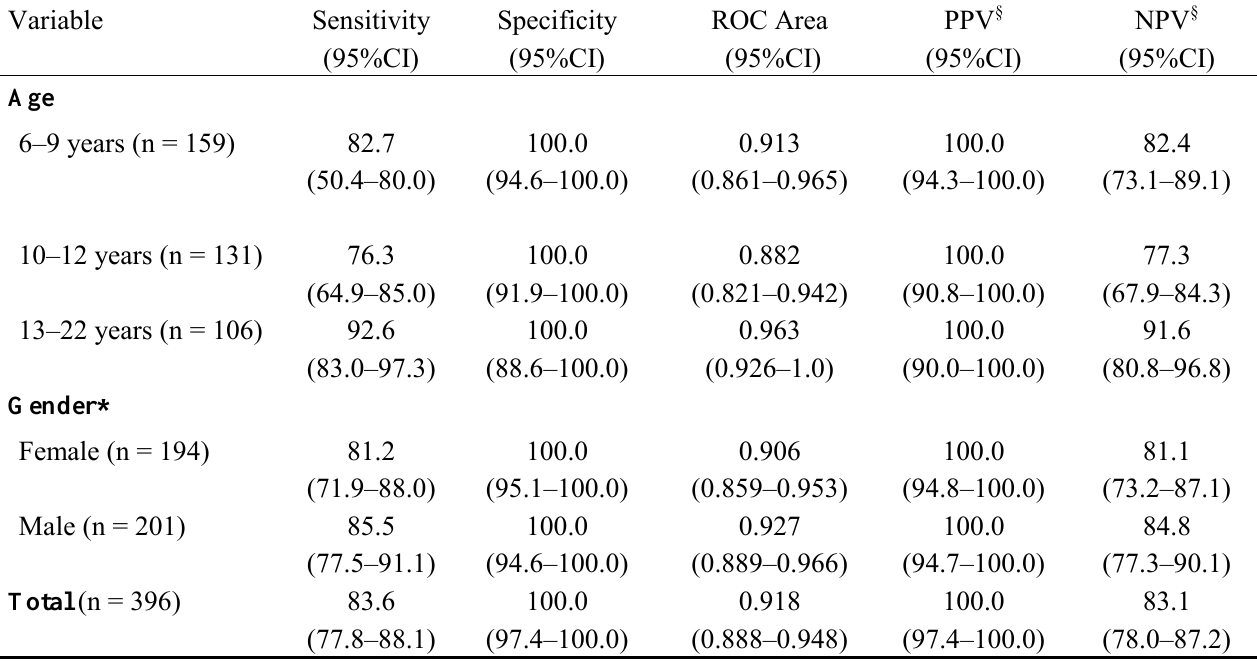
Table 4. Sensitivity, specificity, accuracy, positive and negative predictive values achieved using the simplified TF index to determine the prevalence of severe dental fluorosis (TF ≥ 3) when compared to the gold standard (full mouth TF index), rural communities,